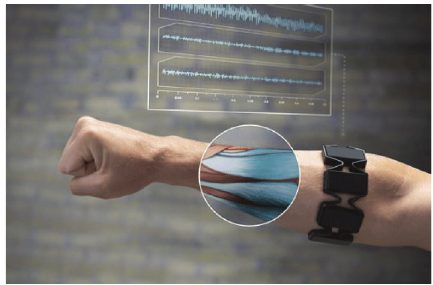
Figure 2: Profile of MYO Armband with 8 channels of sEMG electrodes and the sEMG sampling rate is 200 Hz [38].